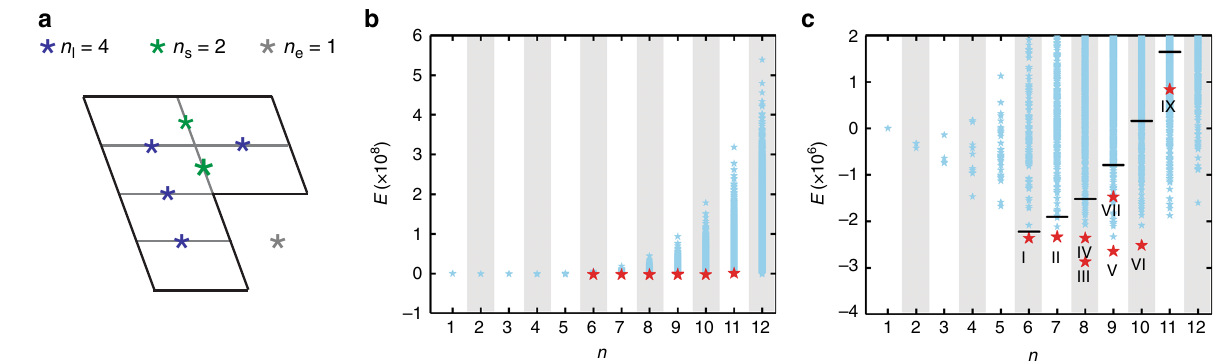
Fig. 4 Mathematical analysis of the observed and theorized fi bril morphologies. a Graphical representation of the de fi nition of the parameters n l , n s , and n e for a given fi bril cross-section. b Plot of E for all theorized fi bril morphologies or cross-sections (blue) vs. n as obtained by the even fi t (gray columns). Hence, only white columns have predictive power for the even fi t. Red symbols: experimentally observed fi bril morphologies. c Close-up of b . Black horizontal division markers show the 1% cutoff of the most stable morphologies for each